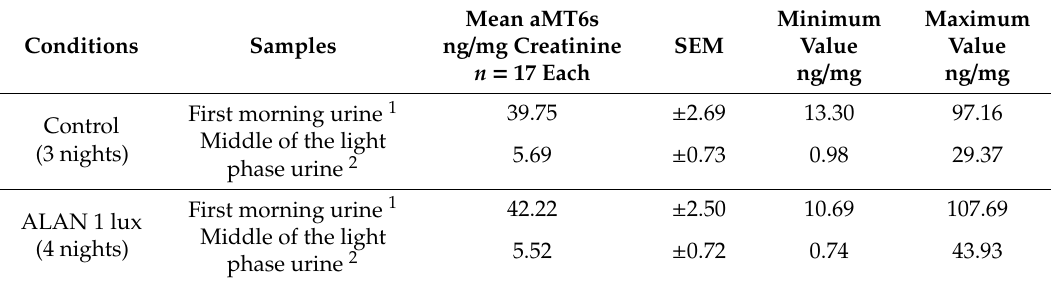
(Table 1). Huge interindividual variability in aMT6s / creatinine concentrations in FMU was recorded among volunteers (Table 1, Appendix A Figure A1). Table 1. Descriptive statistics of aMT6s / creatinine concentrations in urine of healthy volunteers under control and ALAN 1 lux conditions.